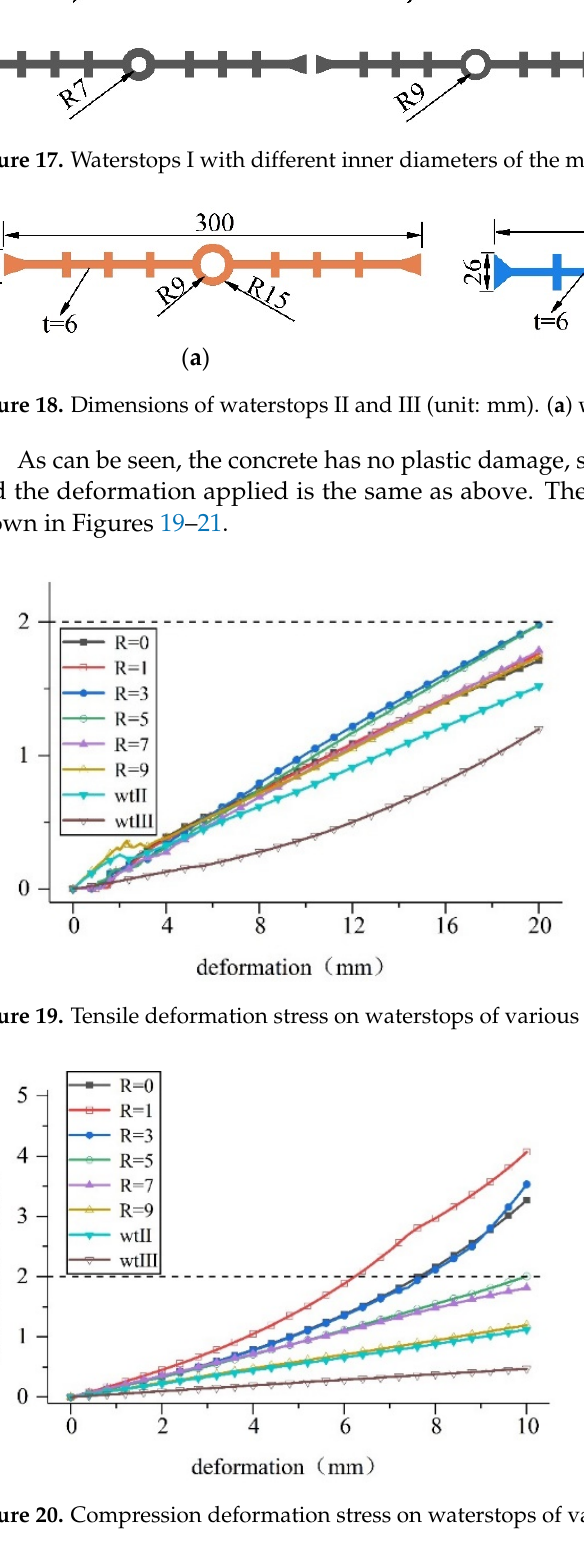
Figure 21. Settlement deformation stress on waterstops of various size. A waterstop is made of rubber, and if it is too thin, it will increase the risk of damage such as tearing and puncturing. The tunnel deformation joint has as designated width. On the premise of satisfying these two conditions, the above analysis shows that stress defor- mation can be improved by reducing the thickness of the waterstop and increasing the inner diameter and size of the hole in the waterstop. This will also reduce the damage to the bond between the waterstop and the concrete due to deformation, and reduce the risk of waterstop failure caused by excessive deformation.